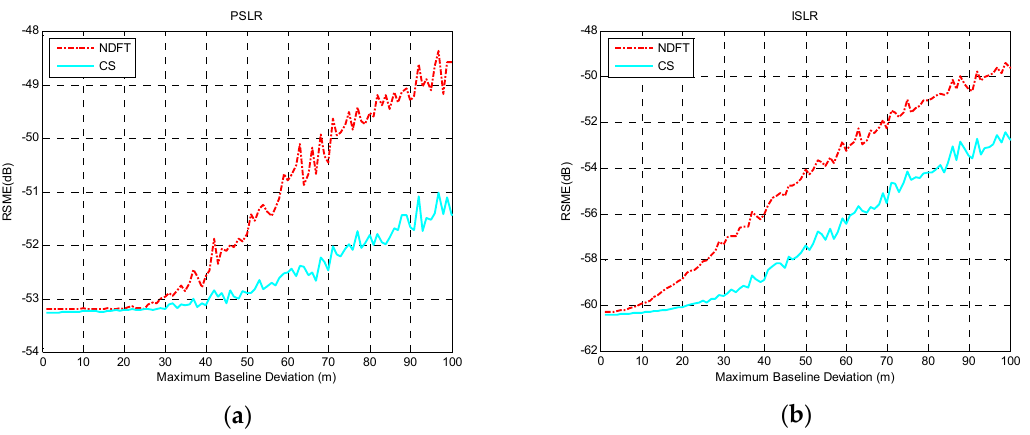
B = : ( a ) PSLR; ( b ) ISLR. Figure 8. The imaging performance with B span = 1000 m: ( a ) PSLR; ( b ) ISLR. span